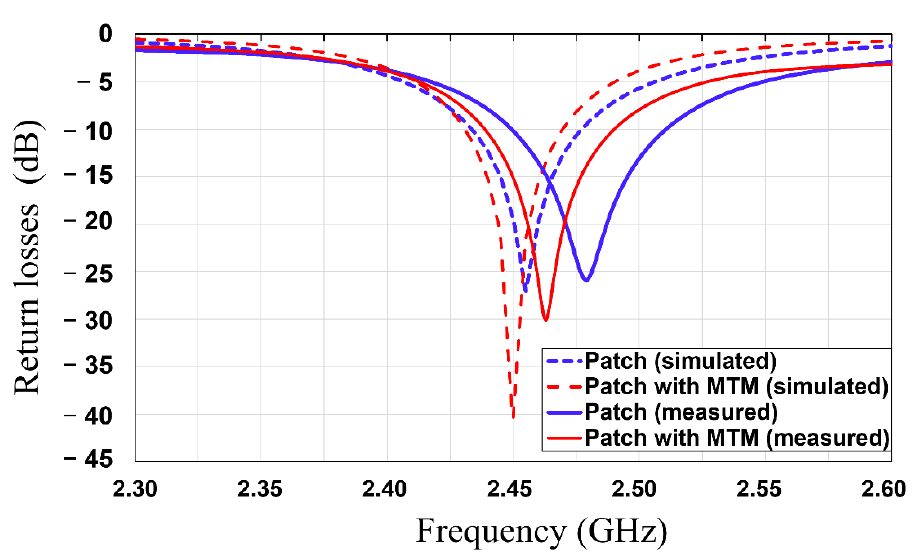
Figure 8. Simulated and measured return loss results of the patch antenna without and with MTM superstrate.